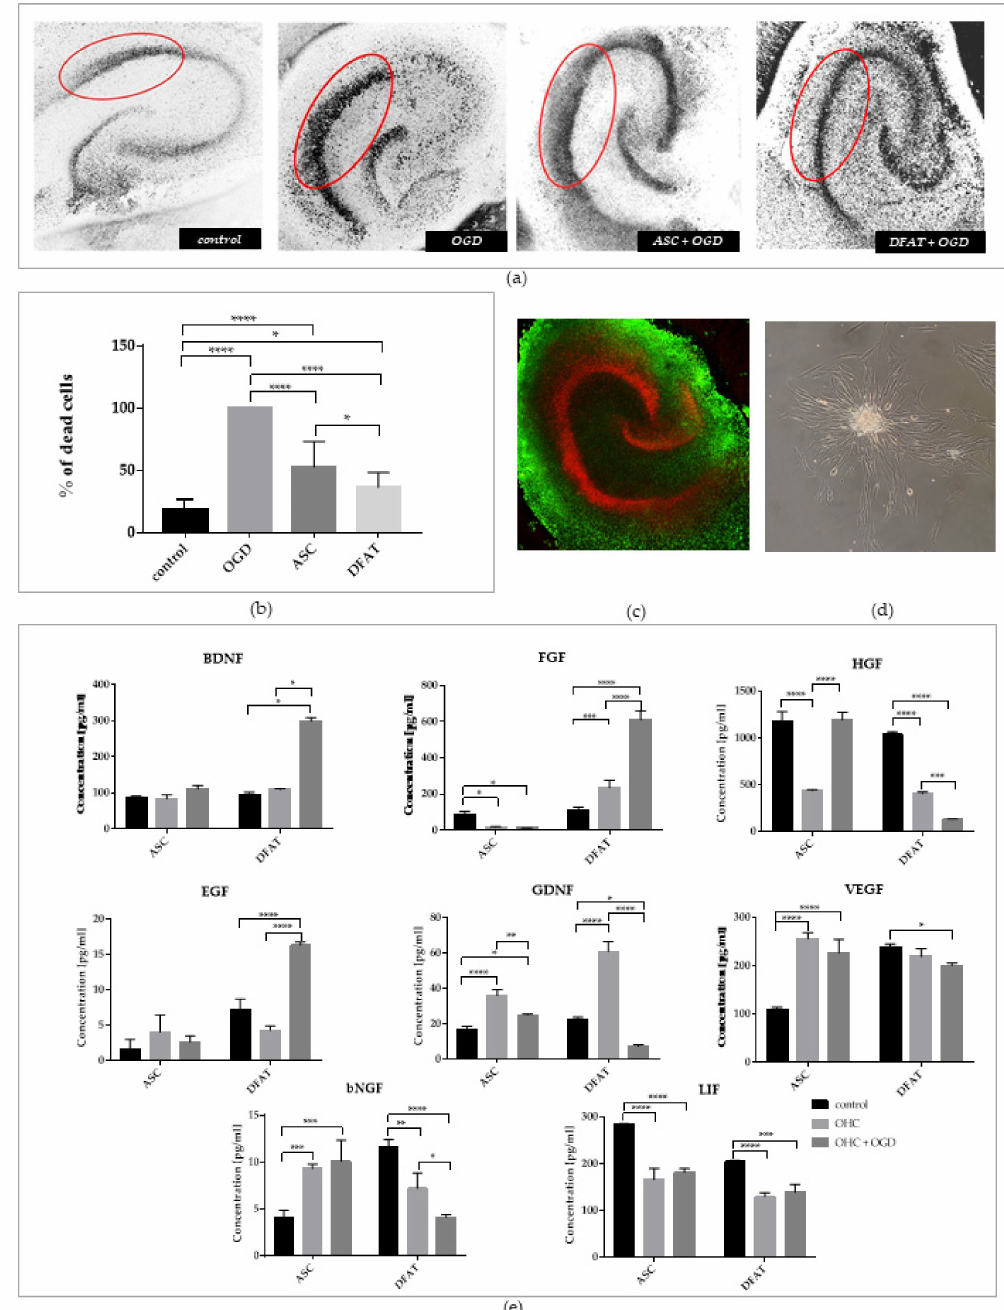
Figure 12. ASCs/DFAT cells neuroprotective and neurogenic potential assessment. ( a ) PI incorporation into the CA1 region of the hippocampal slices (the region is marked red); ( b ) Quantitative analysis of dead cells after OGD in all culture variants.; ( c ) Immunocytochemical analysis of live (green—stained with Calcein) and dead (red—stained with PI) cells of the hippocampal slice; ( d ) The characteristic rosette made by ASCs after the co-culture with OHC; ( e ) Cytokines concentration in medium collected in three culture variants—from cell culture (control), after co-culture with organotypic hippocampal slices (OHC) and with OHC after oxygen-glucose deprivation (OHC+OGD).The results of all presented above experiments are expressed as mean values of three experiments ± SEM. The differences were considered statistically significant when p -value < 0.05. Statistical significance level * for 0.01 < p < 0.05; ** for 0.001 < p < 0.01; *** for 0.0001 < p < 0.001; **** for p <